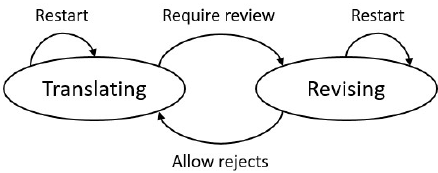
Figure 14. Each transition in the workflow is optional and can be enforced by the translation